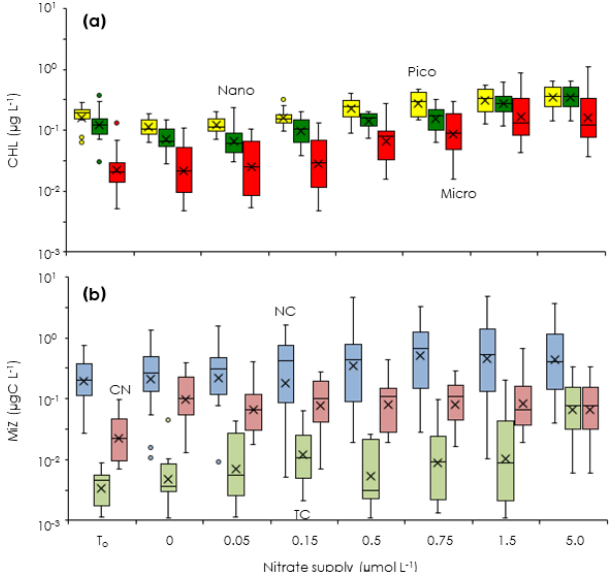
Figure 3. Changes in phytoplankton and microsized heterotroph standing stocks during the gradient-enrichment experiments (EXP a ). (a) Size-fractionated chlorophyll a concentrations (CHL). (b) Microheterotroph standing stocks (MiZ). T o : at the beginning of the gradient-enrichment experiments. 0: no enrichment. 0.05 to 5.0µmolL − 1 : enrichment. Box-and-whisker diagram at each ni- trate concentration was compiled from the results conducted at the eight stations. Box represents first (bottom), second (bar), and third (top) quartiles, and cross marks are the average values. Whiskers in- dicate minimum and maximum values, and circles are outliers. Pico: chlorophyll smaller than 2µm (yellow). Nano: chlorophyll between 2 and 11µm (green). Micro: chlorophyll larger than 11µm (red). NC: naked ciliates (light blue). TC: tintinnid ciliates (light green). CN: copepod nauplii (light